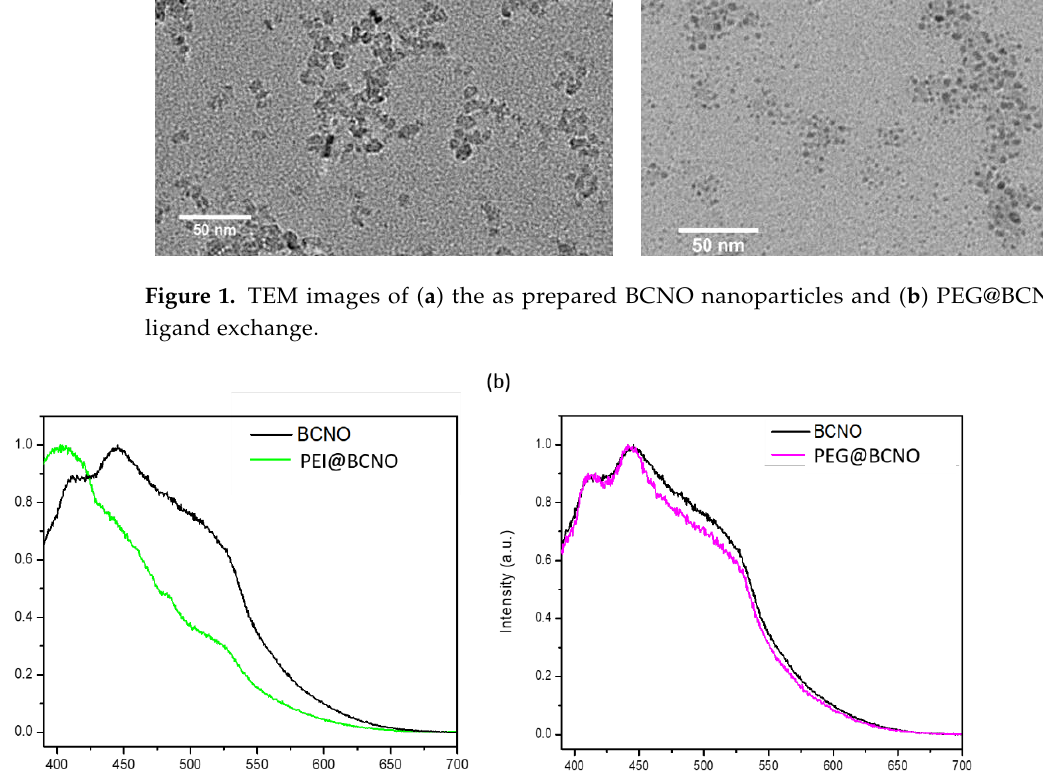
Figure 1. TEM images of ( a ) the as prepared BCNO nanoparticles and ( b ) PEG@BCNO after ligand exchange.